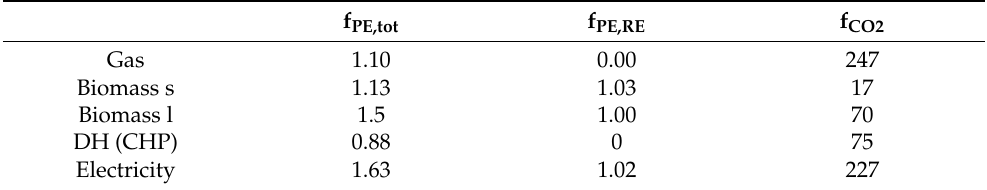
Table 2. Primary energy and CO 2 conversion factors (in Austria, acc. OIB-6:2019).